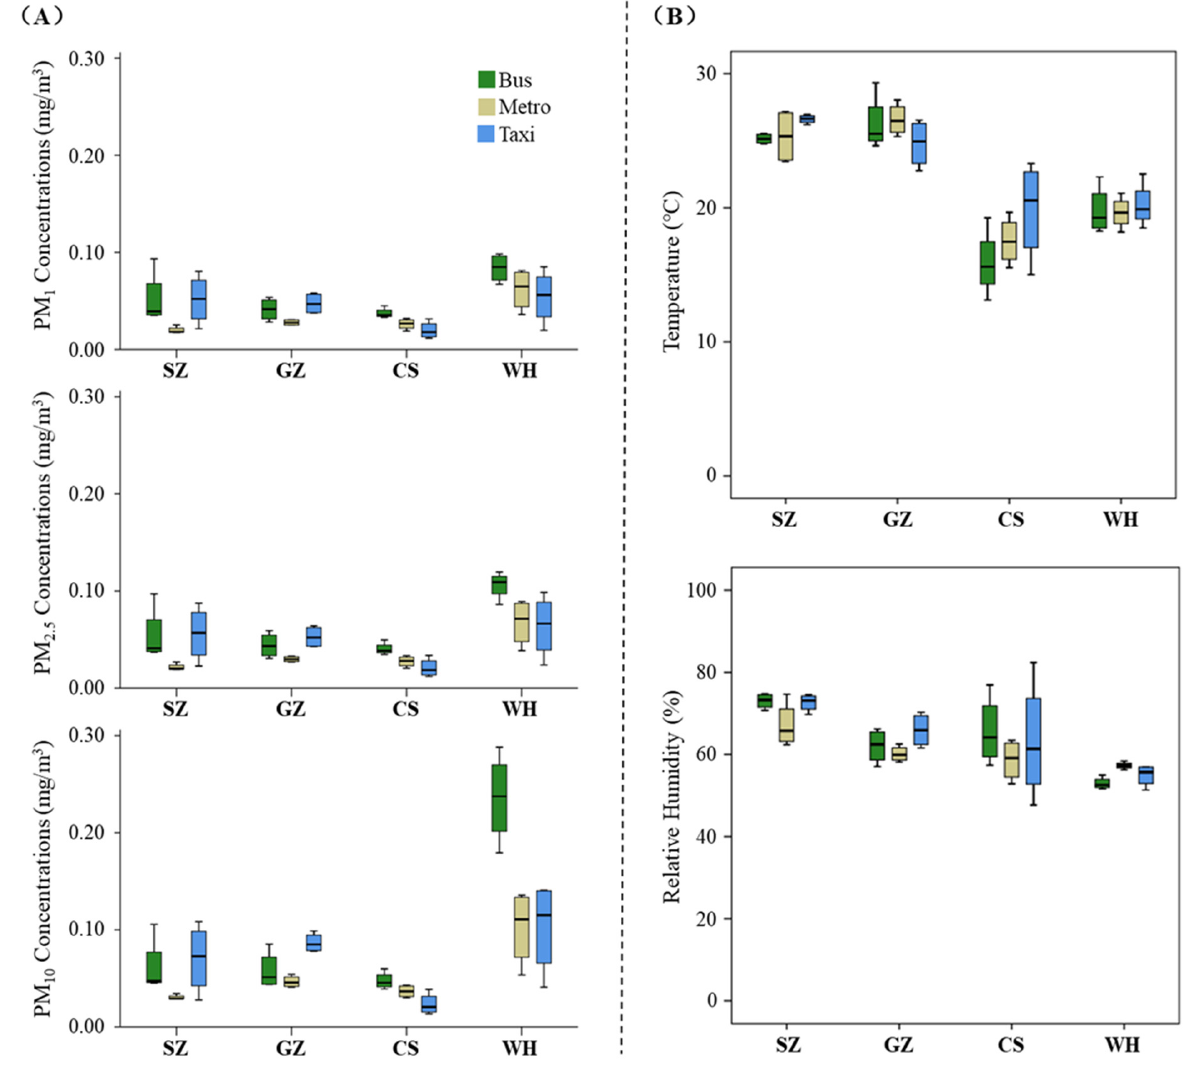
Figure 3. Distribution of in-cabin PM concentrations ( A ) and temperature and relative humidity ( B ) of each transit by City and Mode of transportation.